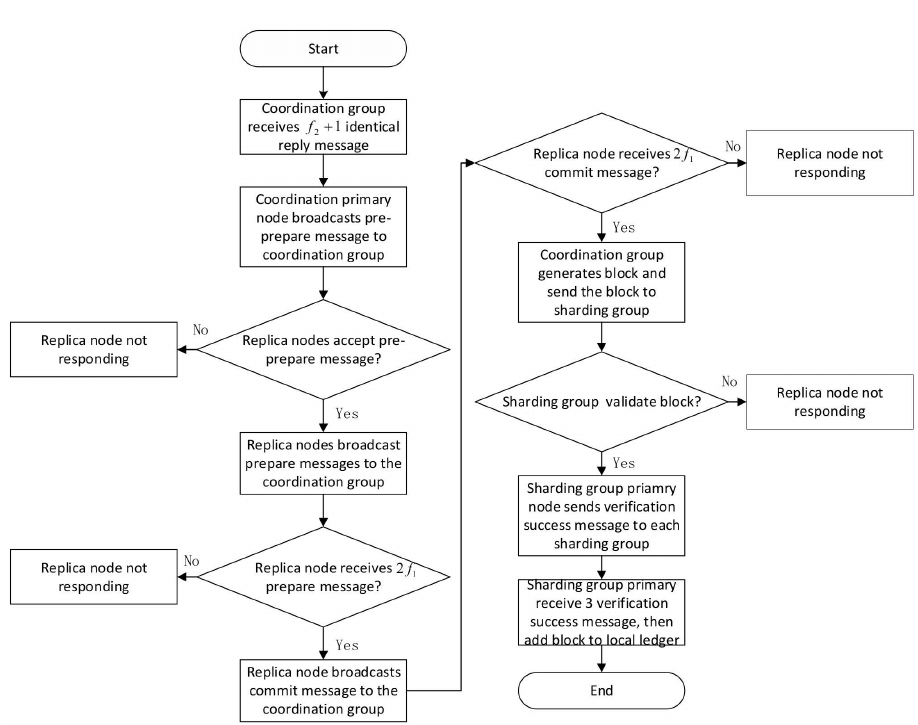
Figure 4. Transaction packaging and validation block flow